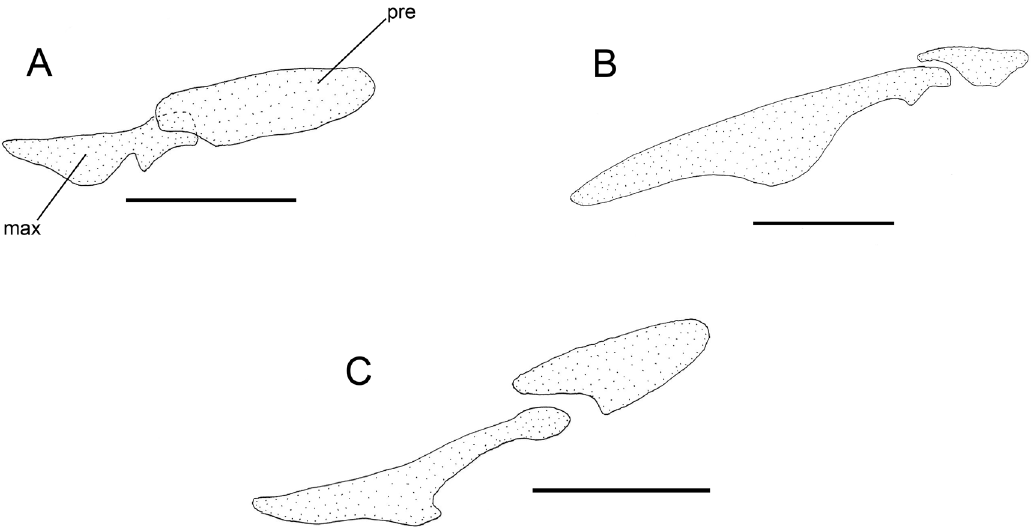
Figure 6. Dorsal view of premaxilla and maxilla. A Cambeva davisi , UFRJ 10713 B Scleronema operculatum , UFRJ 11856. C Scle- ronema sp1., UFRJ 10645. Scale bar: 1 mm max, maxilla; pre,